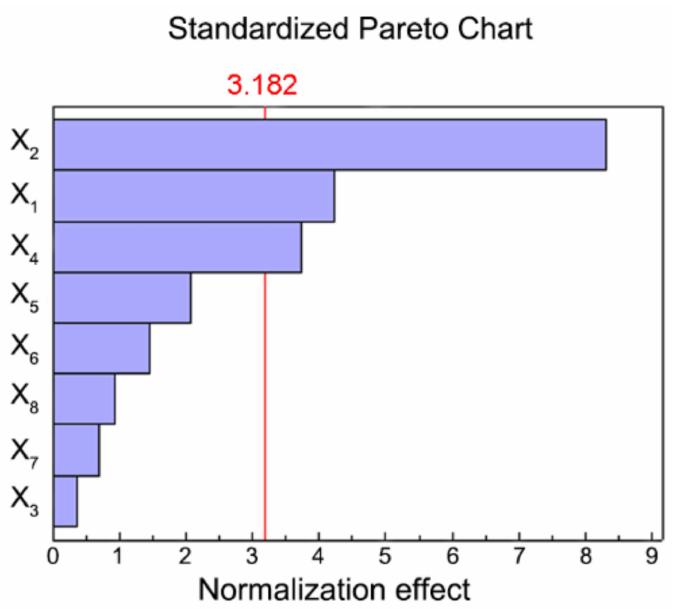
Figure 2. Pareto plot of standardized effects of tested variables on the extraction yield of flavonoids. The red line represents a 95% confidence interval, and exceeding this reference line indicates that the factor has a significant effect on the response